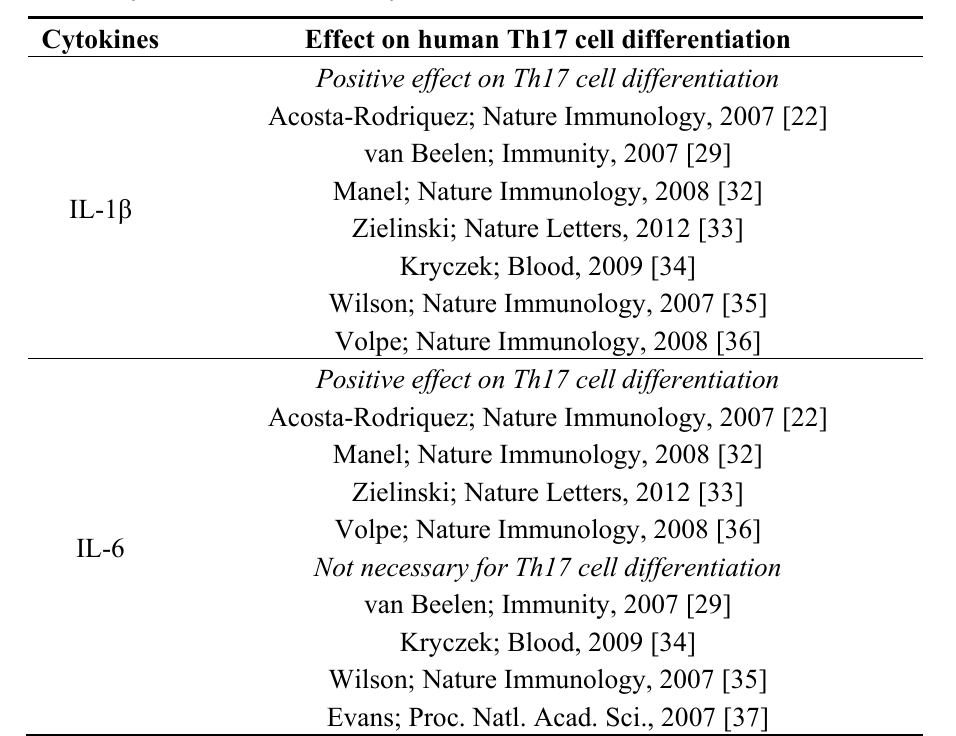
Table 1. Summary of the literature for cytokines involved in human Th17 cell